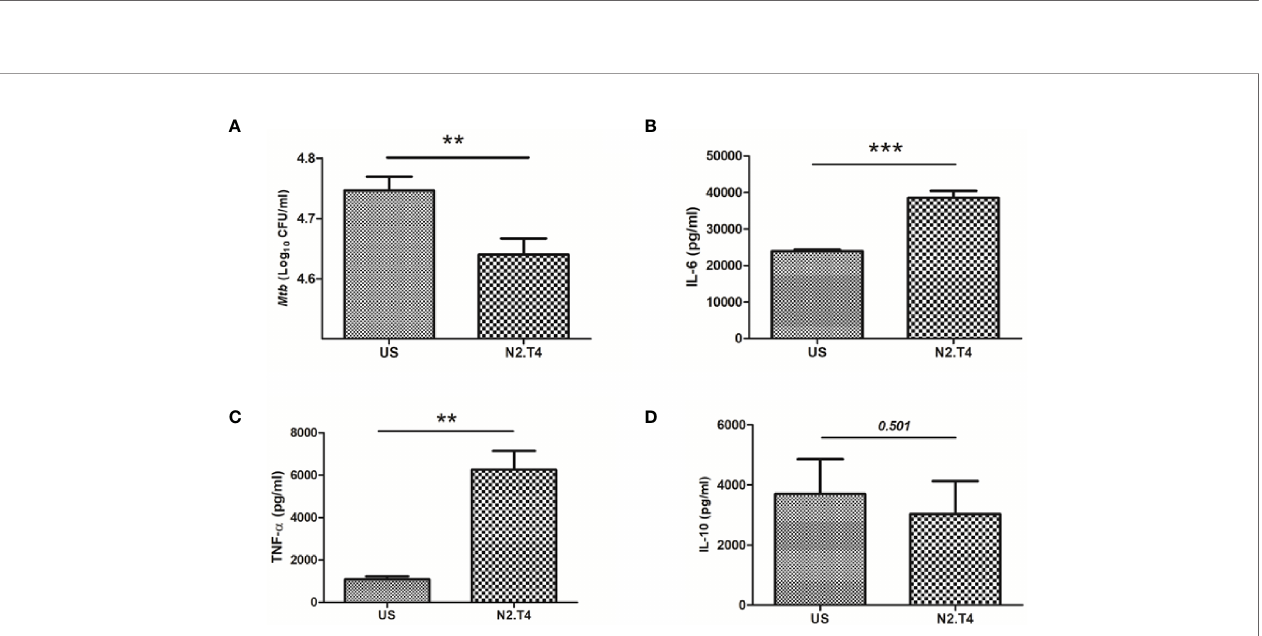
FIGURE 3 | Signaling MSCs through N2.T4 restricted the intracellular growth of Mtb and elicited the secretion of pro-in fl ammatory cytokines. (A) MSCs were infected with Mtb (GFP-H37Ra) for 4h and then stimulated with N2.T4 for 48h. Later, cells were lysed and CFUs were enumerated on 21d by CFU assay. The Bar diagram represents the mean ± SEM and is indicative of three independent experiments. Statistical analysis was done using one-way ANOVA. The culture SNs were collected after 48h for determining the yield of cytokines (B) IL-6, (C) TNF- a and (D) IL-10 by ELISA. Statistical analysis was done using an unpaired t-test. The inset represents p value. **p < 0.01 and ***p < 0.001.